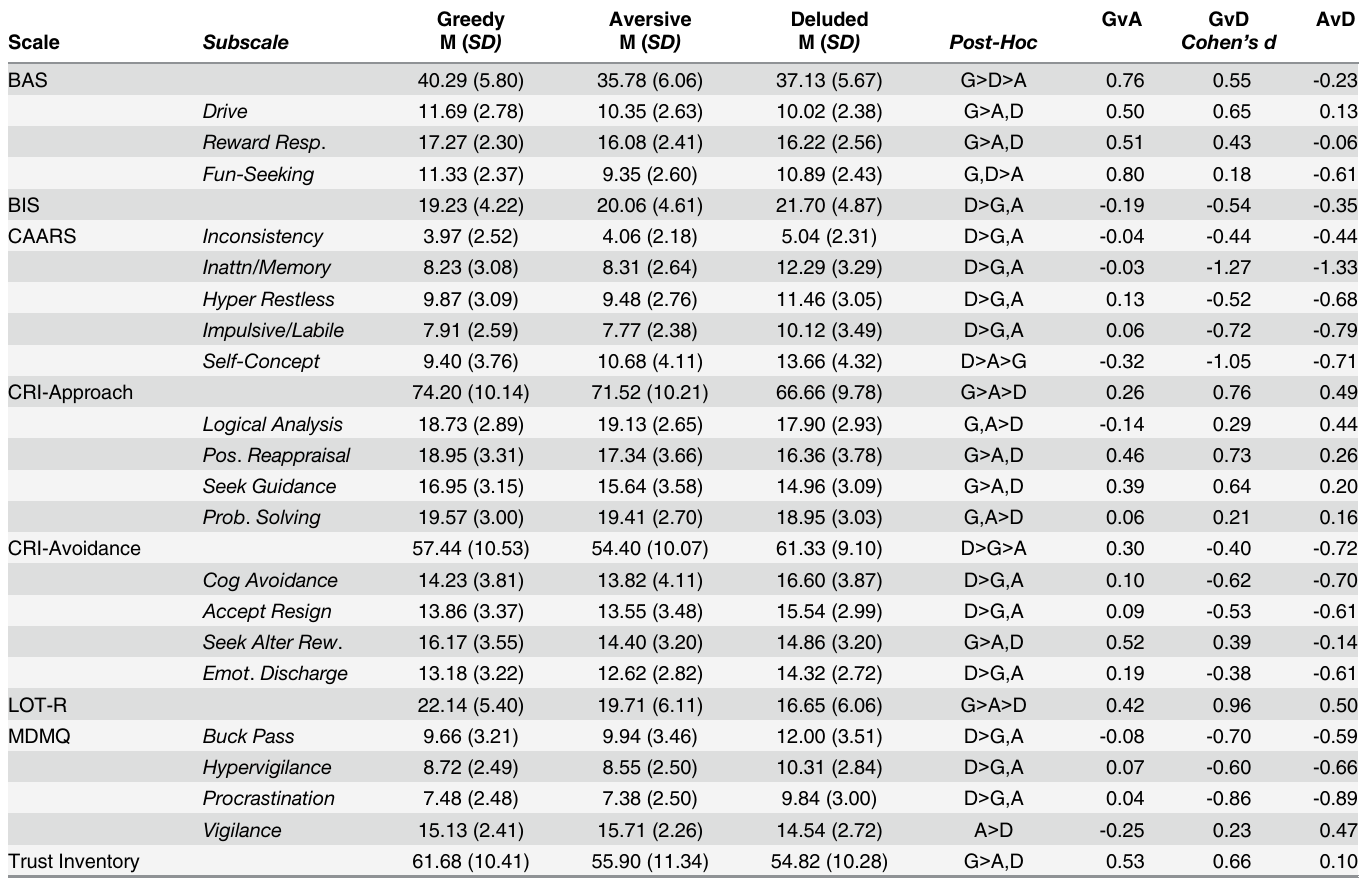
Table 5. Comparison of Groups in Sample 2 on Behavioral